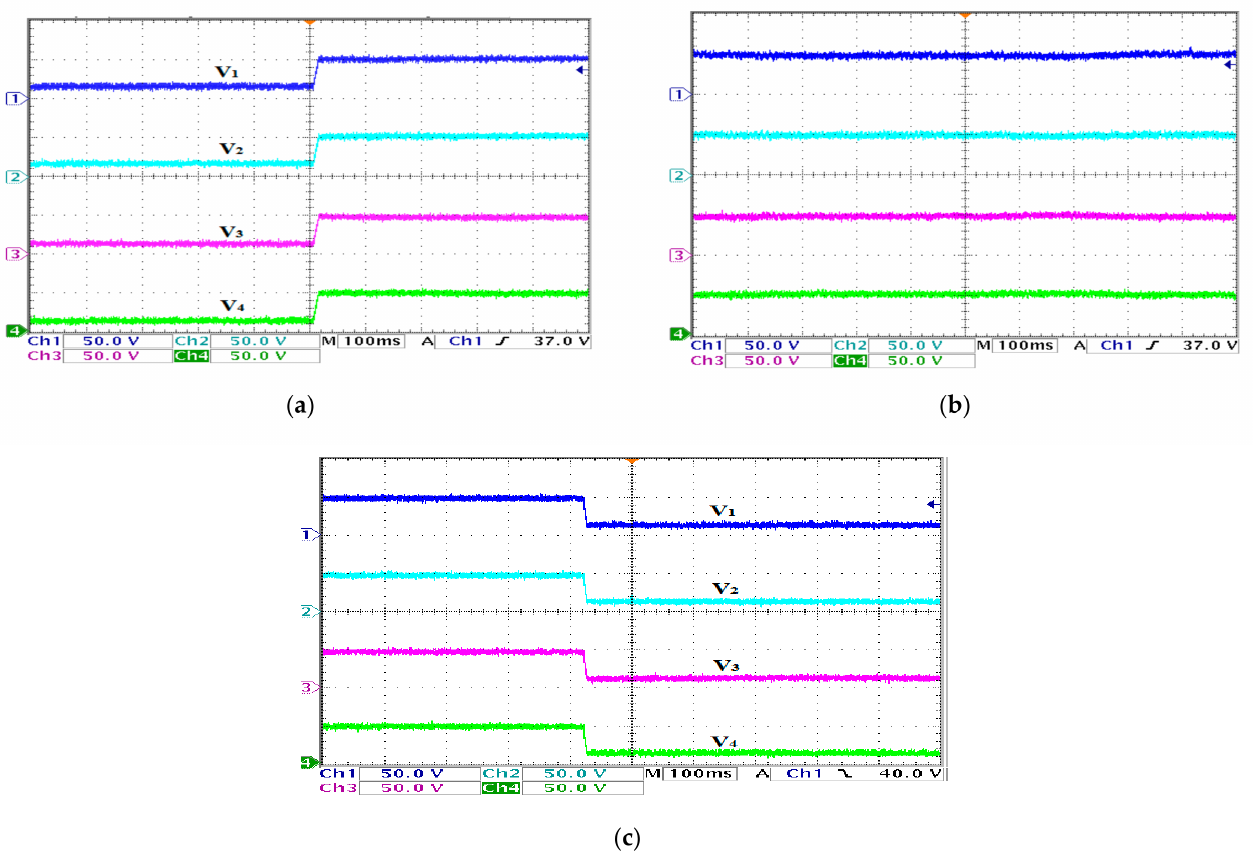
Figure 13. Experimental results of the capacitor voltages (V 1, V 2 , V 3 and V 4 ) with online tuning for a step response with V in changes between 60 V and 200 V. ( a ) Step-up response ( b ) Steady-state condition ( c ) Step-down response.